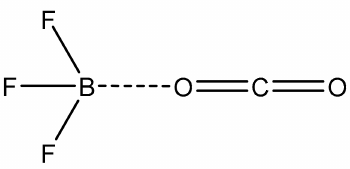
Figure 1. Structure of the BF 3 -CO 2